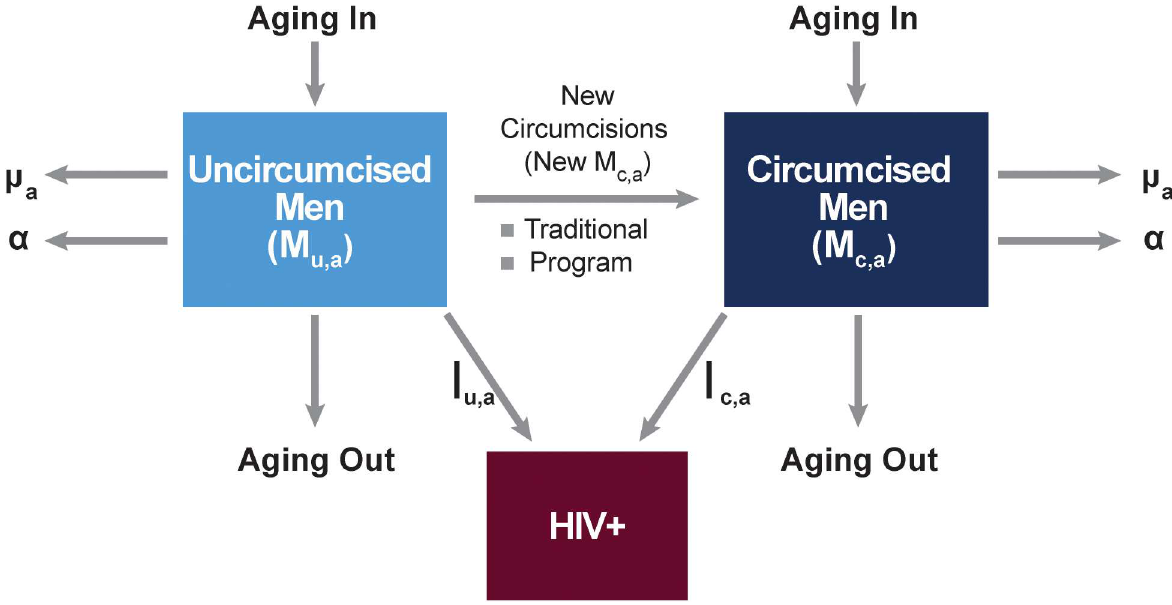
Fig 1. Structure of the DMPPT 2.0 model. μ , non-AIDS mortality; α , AIDS-related mortality; I u , a , , HIV incidenceof uncircumcised men; I c , a , HIV incidenceof circumcised